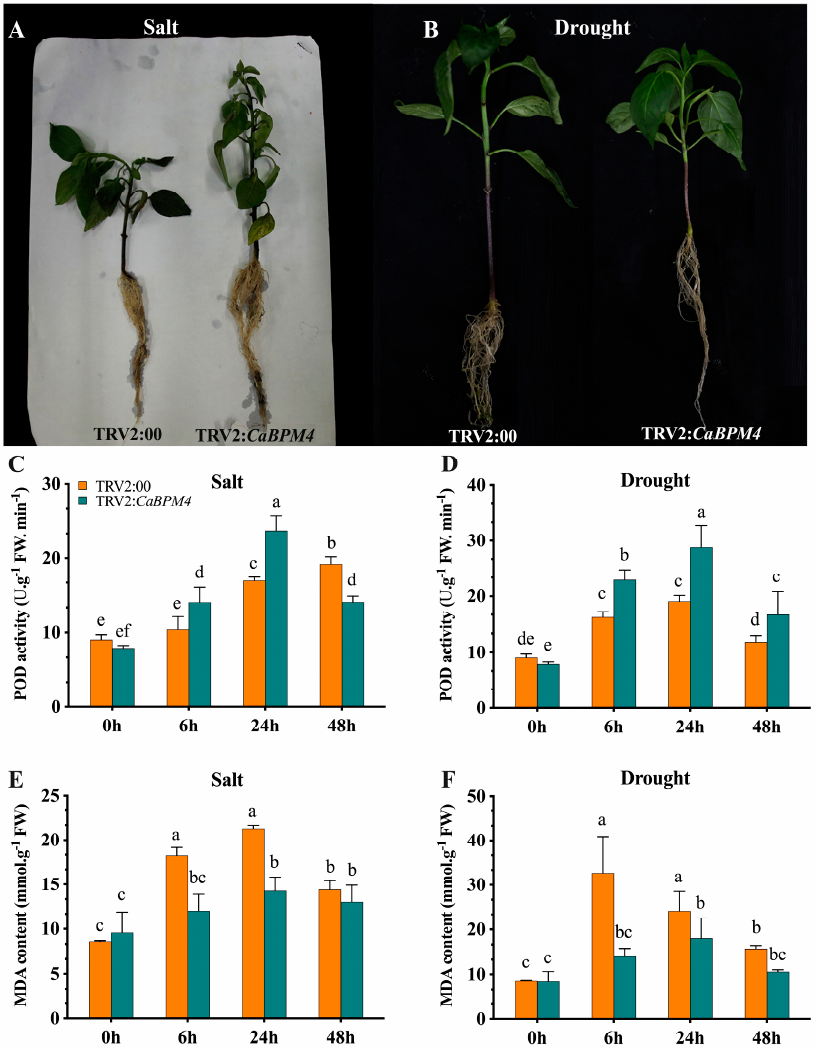
Figure 9. Physiological attributes of CaBPM4 -silenced and control pepper plants under salt and drought stress. ( A ) Phenotypes of the gene-silenced plants in response to salt stress; ( B ) phenotypes of the gene-silenced plants in response to drought stress; ( C ) the activity of POD after salt stress; ( D ) the activity of POD after drought stress; ( E ) MDA concentration after salt stress; ( F ) MDA concentration after drought stress. Values are the means ± SD from three independent experiments. Small letters (a-e) represent significant differences ( p < 0.05).